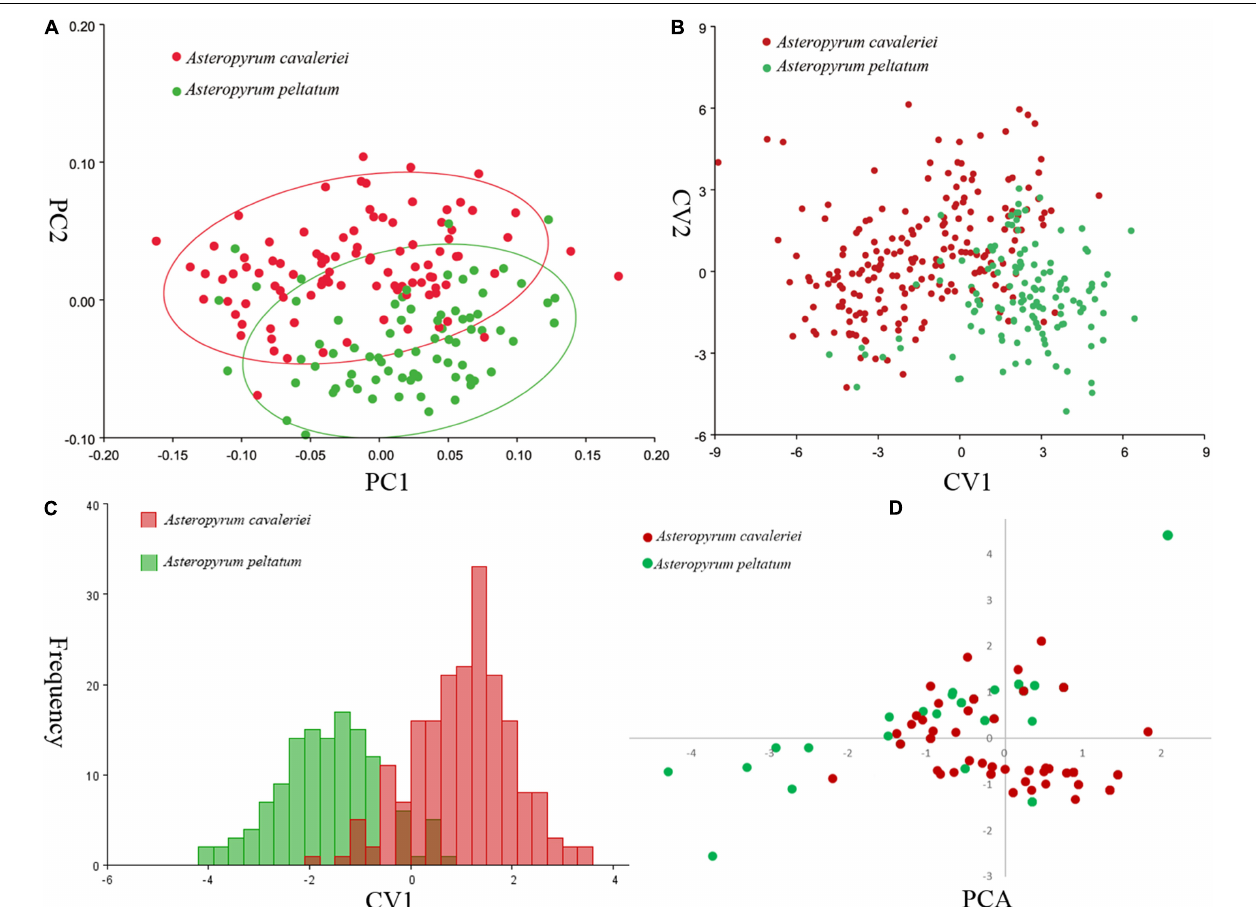
FIGURE 3 | Comparisons of leaf shape of two morphospecies of Asteropyrum using principal component analysis (PCA, A ), canonical variate analysis (CVA, B ), discriminant analysis (DA, C ), respectively. Multivariable plots of the 19 bioclimatic variables in Asteropyrum using PCA method (D) .